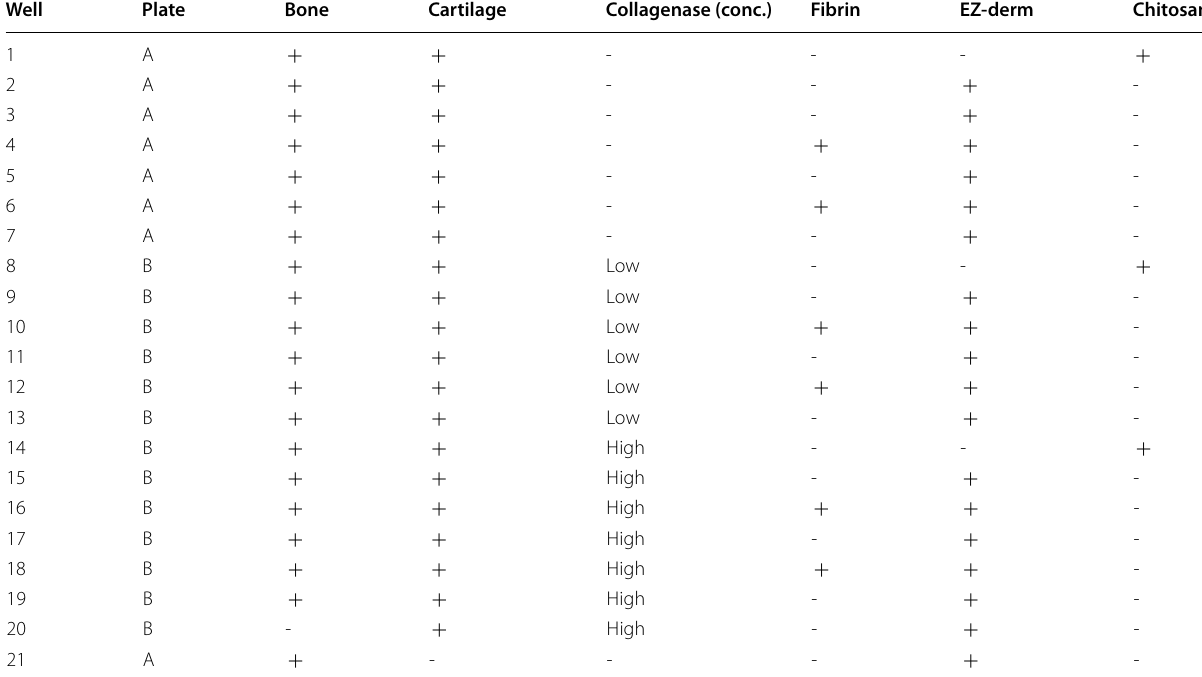
Table 1 Eight weeks of culture in CellCrown ® . Perforated PET membrane in all groups. Some groups weren’t pretreated with collagenase while the others were predigested with both low and high enzyme concentrations. Some groups didn’t contain any scaffold, some groups contained fibrin, some groups EZ-derm ® , while other groups contained chitosan- based scaffold. Upper compartment with PET membrane was fixated, emerged in paraffin and histology sections were made. Hematoxylin, eosin and trichrome staining was done. Immunohistochemistry analysis for four markers was performed: procollagen type I and II, SOX-9 and S-100 Well Plate Bone Cartilage Collagenase (conc.) Fibrin EZ-derm